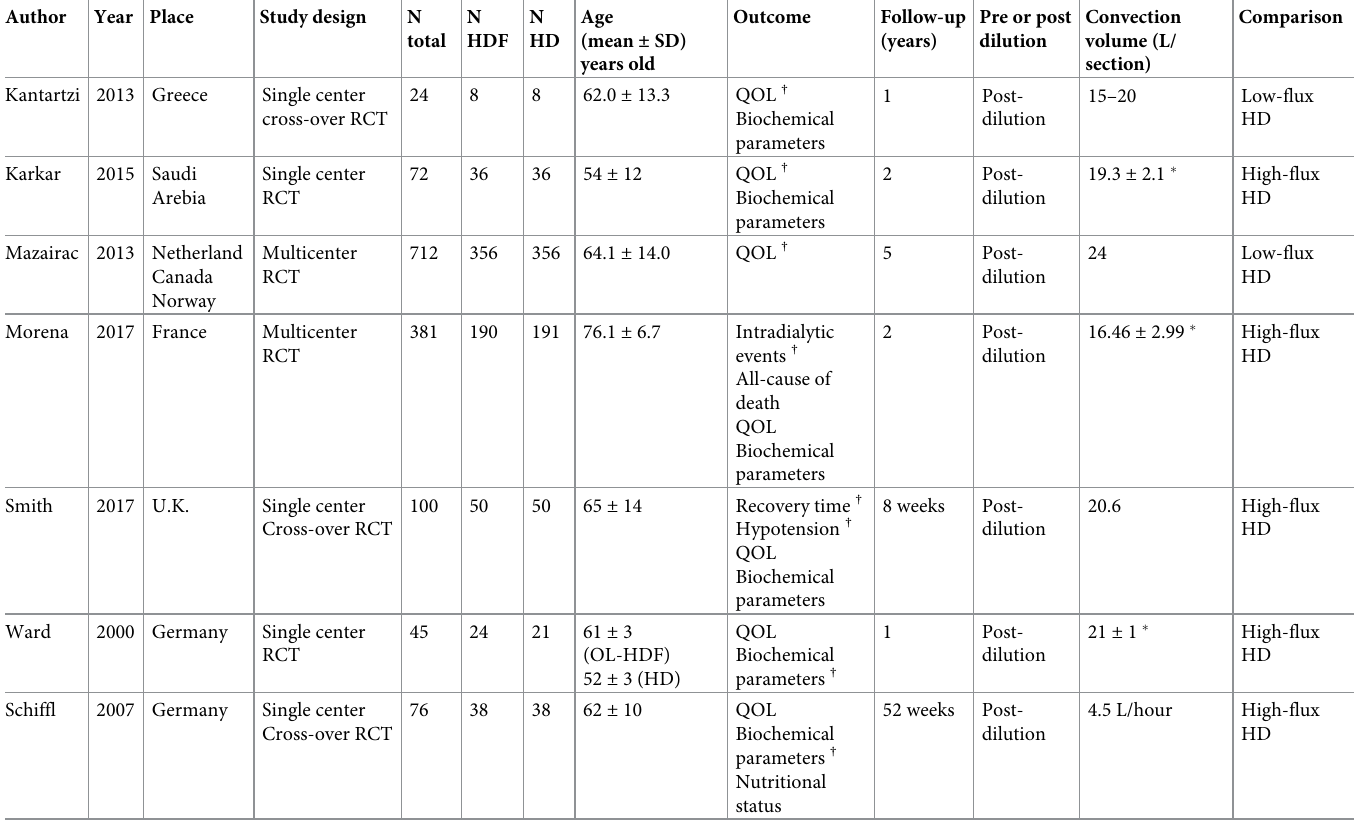
Table 3. Trial description and baseline characteristics.